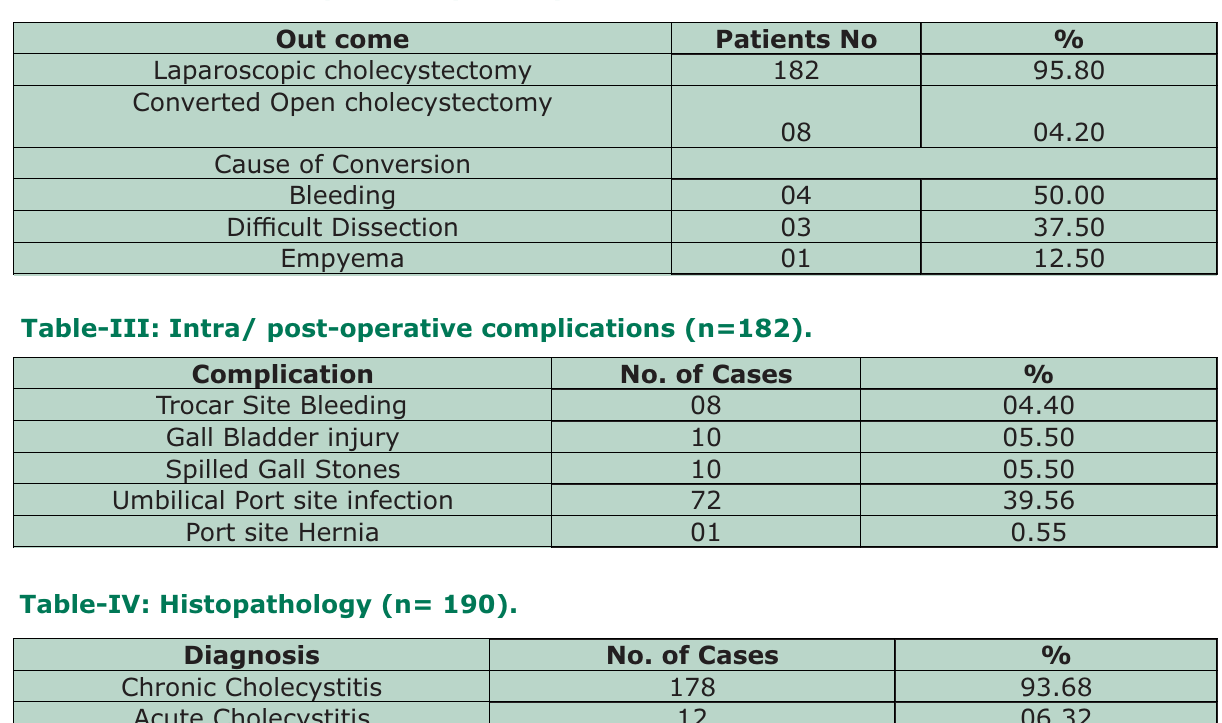
Table-II: Outcome of patients (n=190).